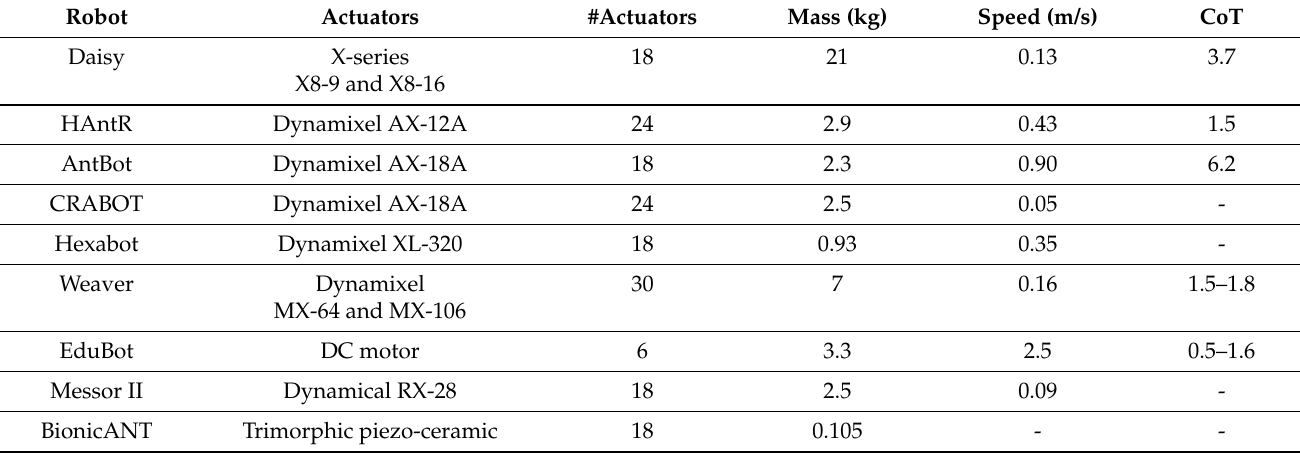
Table 2. Level of performance in terms of cost of transport (CoT) in hexapod robots walking in tripod locomotion over a flat terrain. The speed is the maximum